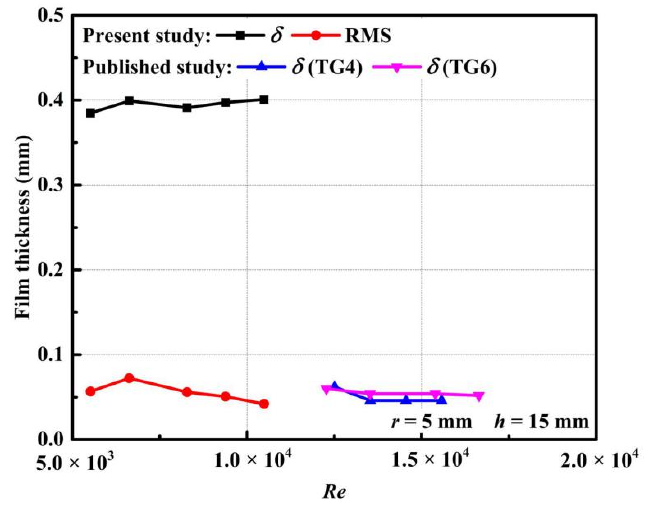
Figure 13. Comparison between the present study and published study.